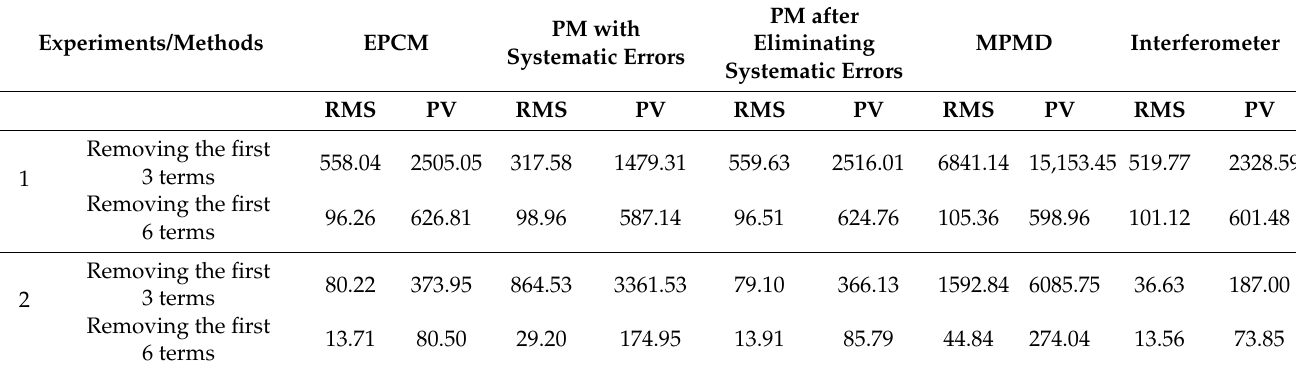
Number 1 represents the planar window glass, and number 2 represents the optical planar